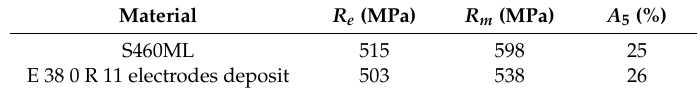
Table 2. Mechanical properties of used materials in accordance with manufacturer data.